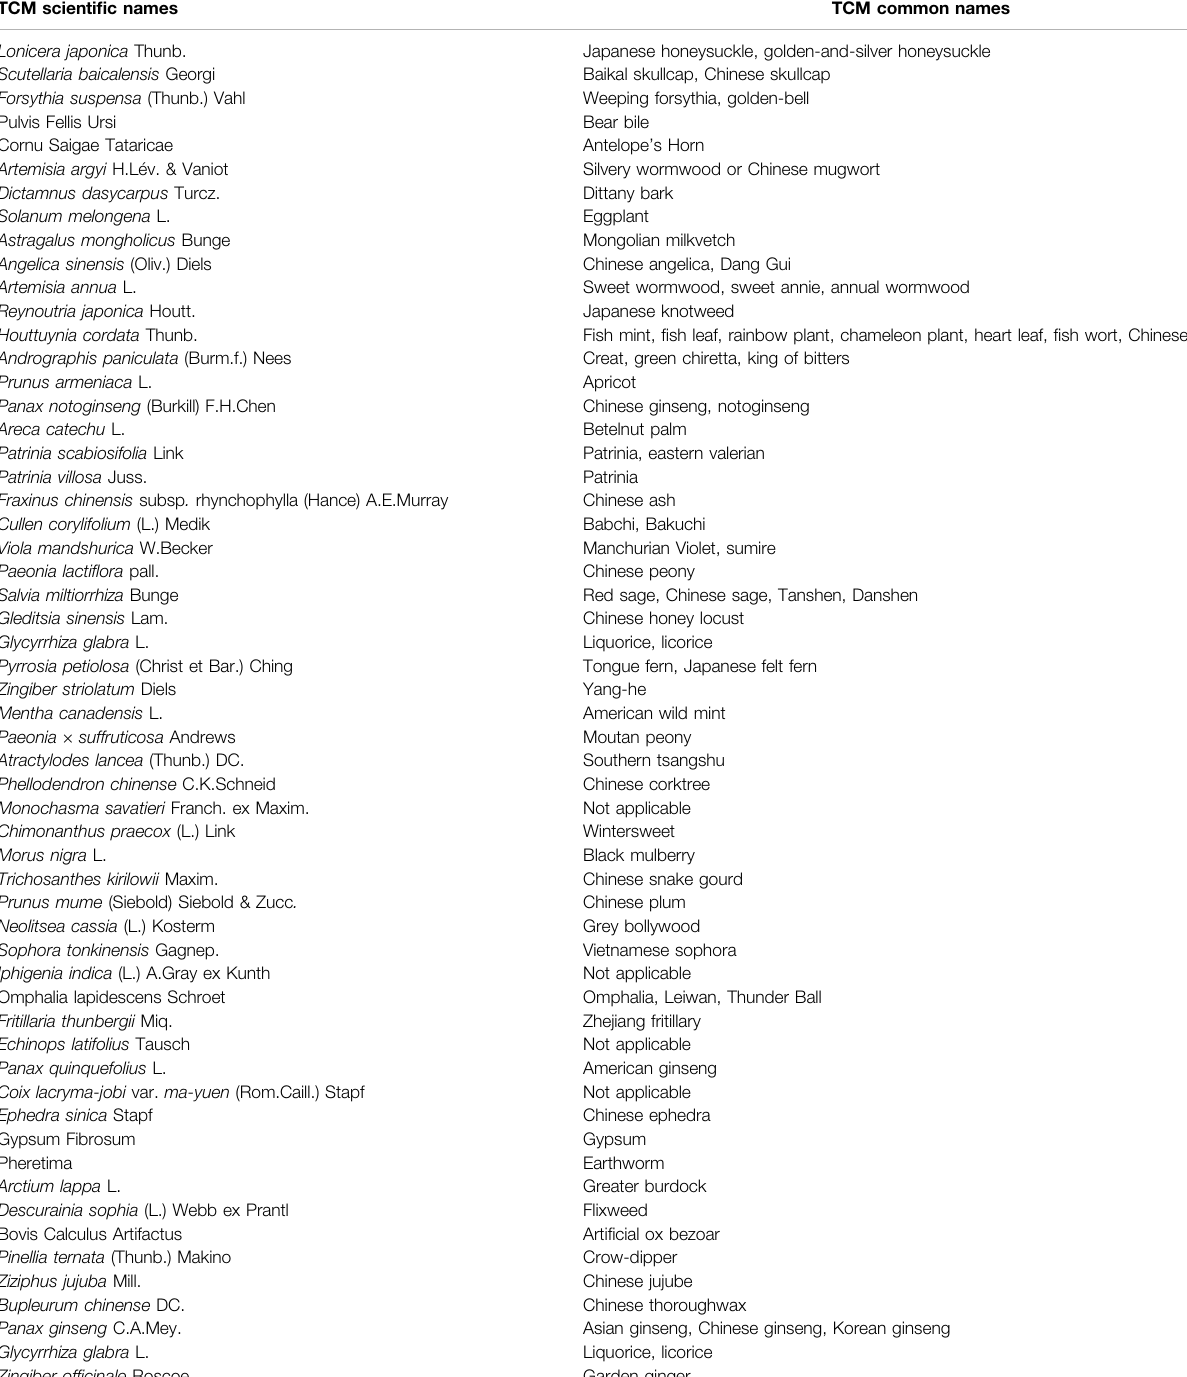
TABLE 1 | Summaries of the scienti fi c and common names of TCM